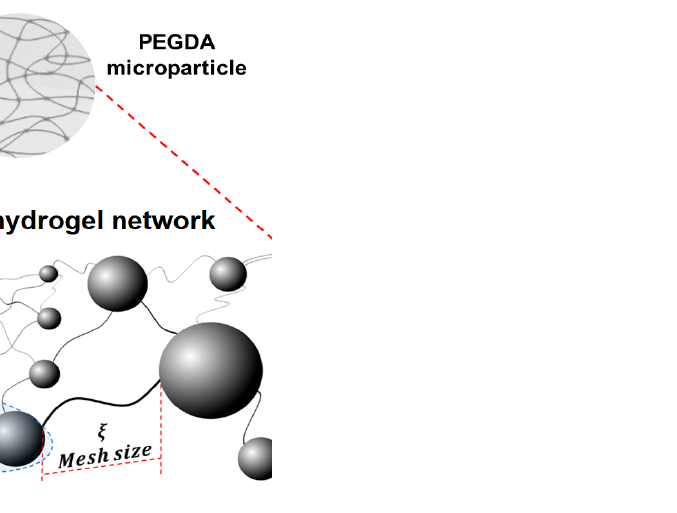
Figure 13. Cross-linked structure of a hydrogel showing mesh size ( ξ ) and average molecular weight ( M c ). Increasing the concentration of the PEGDA increases the number of acrylate groups which will lead to a formation of higher numbers of free radicals and, therefore, a faster formation of a cross-linked structure, [46–48].